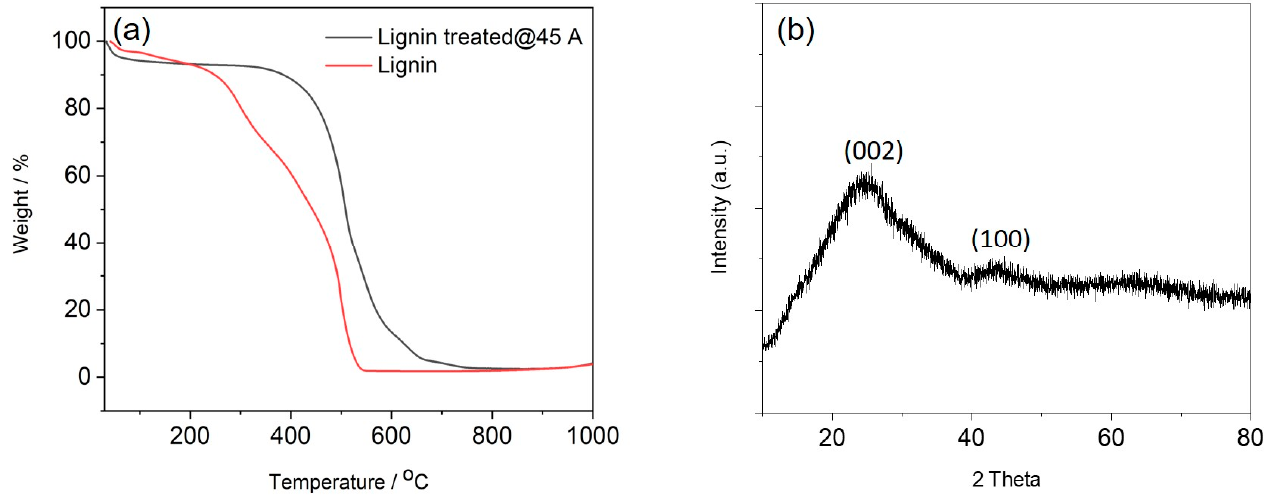
Figure 5. ( a ) Thermogravimetric analysis (TGA) results of lignin fibres and fibres treated with 45 A arc current, ( b ) XRD pattern of carbon fibres produced with 45 A arc current. Table 2. Elemental analysis of untreated lignin fibre and arc-discharged-treated fibre (at 45 A). Material Lignin fibres Arc-discharge-treated car- bon fibres (at 45 A)